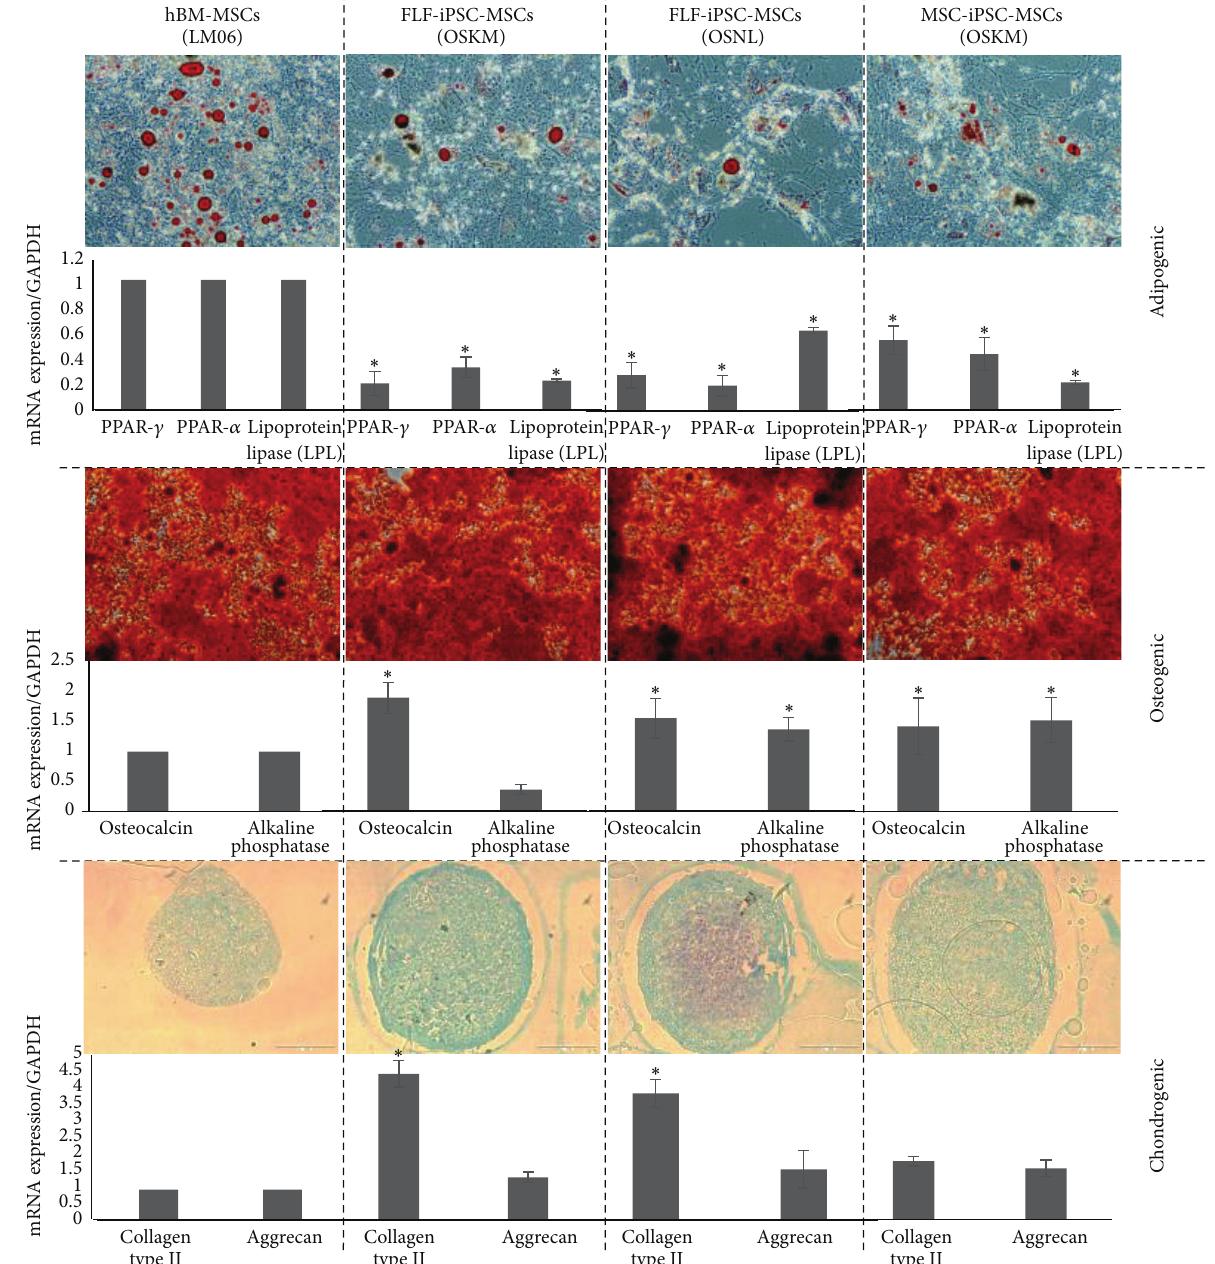
Figure 4: Adipogenic, osteogenic, and chondrogenic differentiation potential of hiPSC-MSCs and BM-MSC (LM06). Oil Red-O staining for lipid formation, alizarin red staining of mineralized deposits, and alcian blue staining for chondrocyte pellet formed by the three iPSC-MSC- like cell lines. mRNA expression level of the relative expression of genes associated with adipogenesis PPAR 𝛾 , PPAR 𝛼 , and LPL, osteogenesis (osteocalcin and alkaline phosphatase), and chondrogenesis (collagen type II and aggrecan). The data represent the mean expression values normalized to the housekeeping gene GAPDH. ∗ : significance difference with BM-MSCs 𝑝 ≤ 0.05